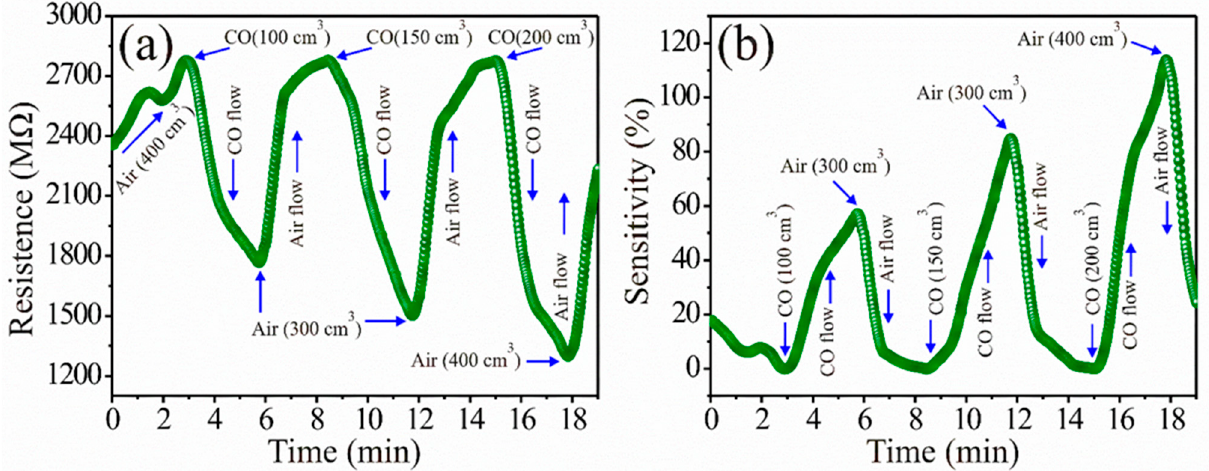
Figure 9. Sensing tests at 200 °C and different CO and air flows as a function of time: ( a ) variation of electrical resistance, ( b ) variation of sensitivity percentage.